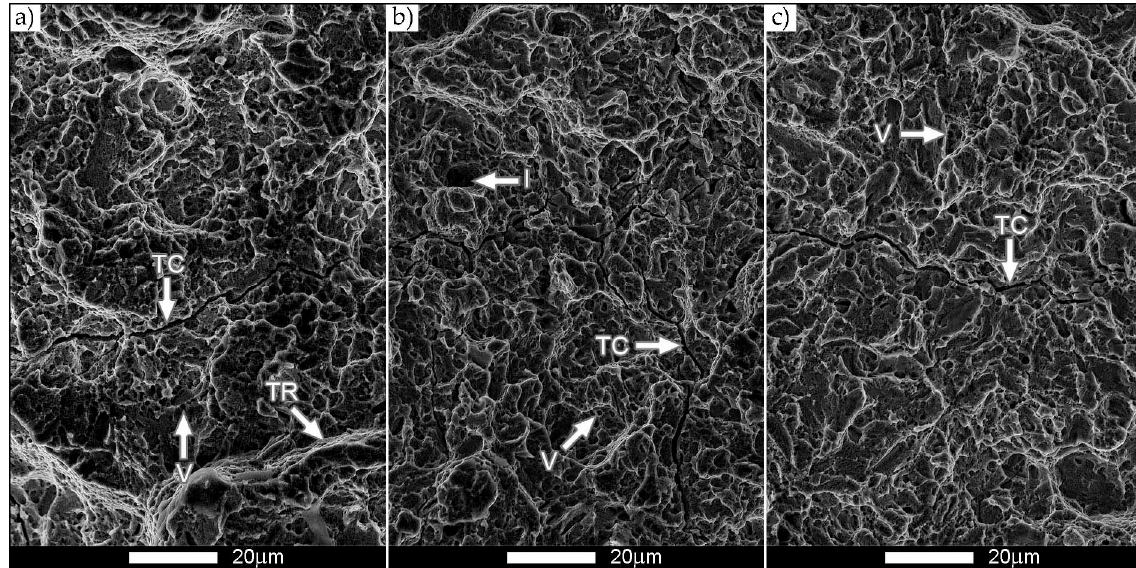
Figure 12. Images of the Hardox Extreme steel fracture surface in delivery state shown in Figure 9: longitudinal orientation ( − 40 °C). ( a ) The area marked with the A1 frame. ( b ) The area marked with the B1 frame. ( c ) The area marked with the C1 frame. TR—tear ridges, V—microvoids, TC—transversal cracks. SEM, non-etched state.